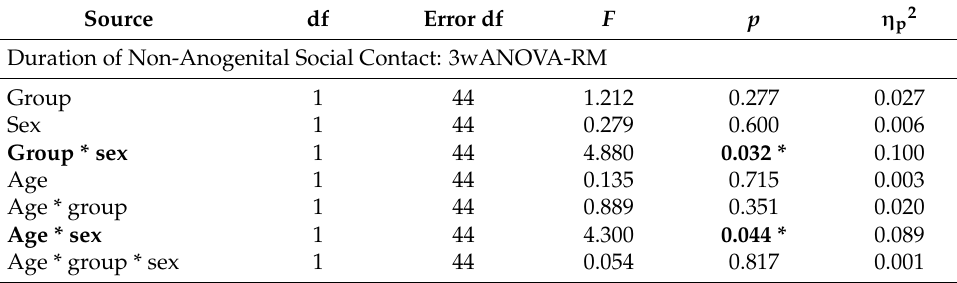
Table A4. Three-way ANOVA-RM table for social interaction